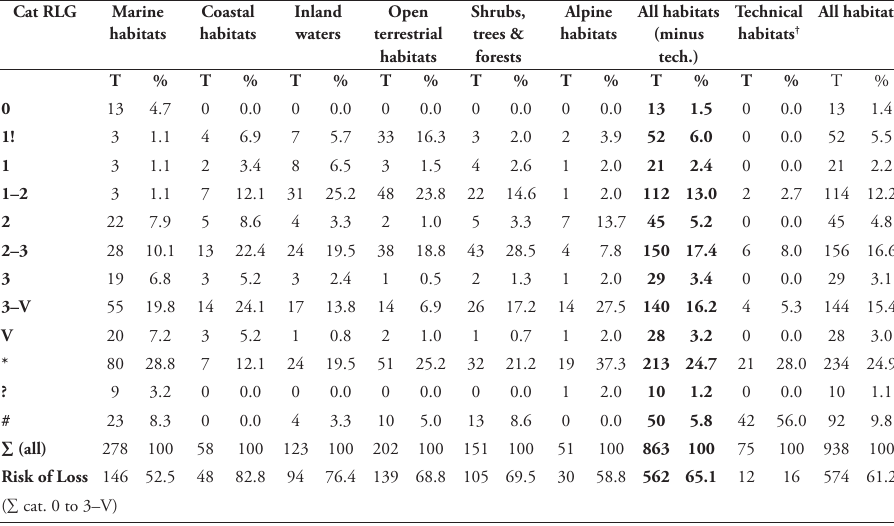
† Technical habitats: Group of anthropogenic habitats (e.g. buildings, roads, landfills) which have generally less significance for nature conservation. In special cases they can function as substitute habitats for species which are adapted to habitat conditions of settlement areas. Threats to this habitat group are mostly characterised by intensification of usage (e.g. sealing), restoration or demolition of old, historic